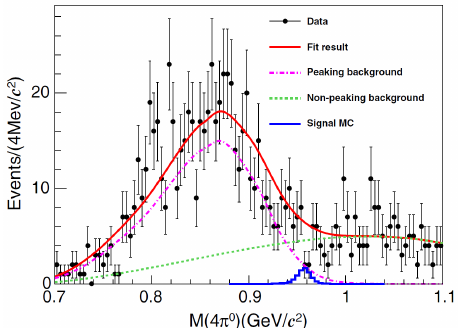
Figure 3: π 0 π 0 π 0 π 0 invariant mass spectrum in η (cid:48) signal region. The black dots with error bars are data, the red line is fit result without signal, the blue histogram is the excepted signal contribution shown with arbitrary normalization, the other lines represent contributions from different backgrounds. The plot is reproduced